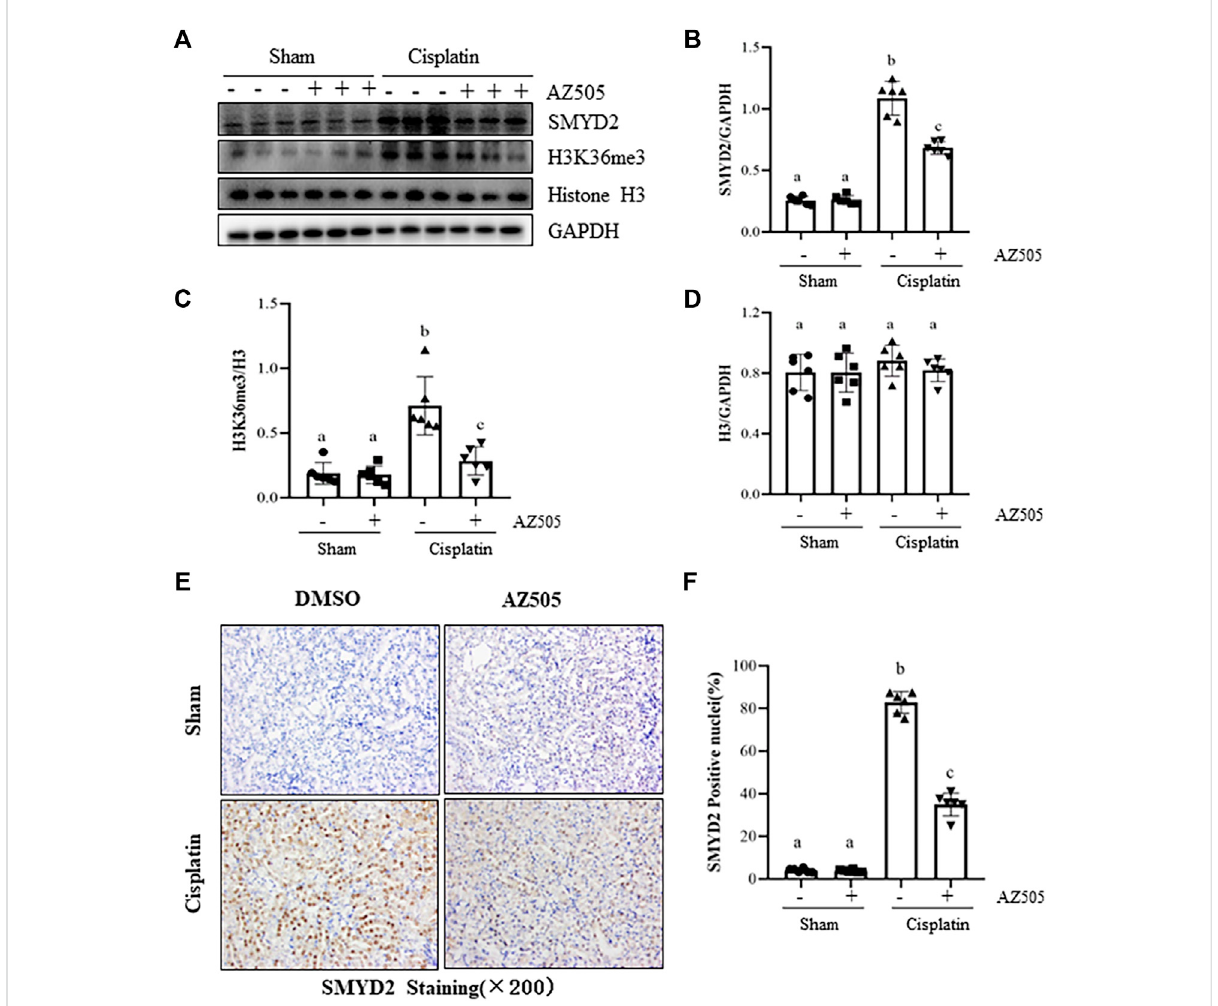
Administration of AZ505 inhibits cisplatin-induced expression and activation of SMYD2. Mice received cisplatin-injection and AZ505 administration as described in Materials and Methods. (A) The kidney tissues were taken for immunoblot analysis of SMYD2, H3K36me3, HistoneH3andGAPDHasindicated.Representativeimmunoblotsfrom3experimentsareshown. (B – D) ExpressionlevelsofSMYD2 (B) ,andHistone H3 (D) were quanti fi ed by densitometry and normalized with GAPDH,along with H3K36me3 (C) normalized with Histone H3 as indicated. (E) Photomicrographs illustrate immunohistochemical staining for SMYD2 in the kidney tissues with or without AZ505 treatment (×200). (F) The graph showsthepercentageofSMYD2-positivenucleis(brown)relativetothewholenucleisfrom10randomcortical fi elds(×200).Dataaremeans±S.E.M. ( n = 6). Means with different superscript letters are signi fi cantly different from one another ( p <